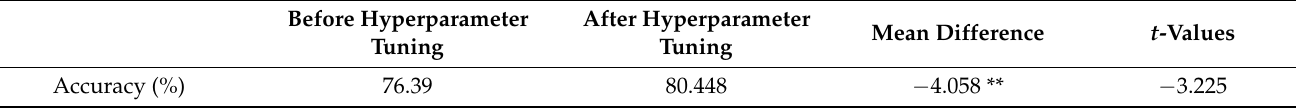
Table 9. Mean differences of accuracy before and after hyperparameter tuning using t -test.